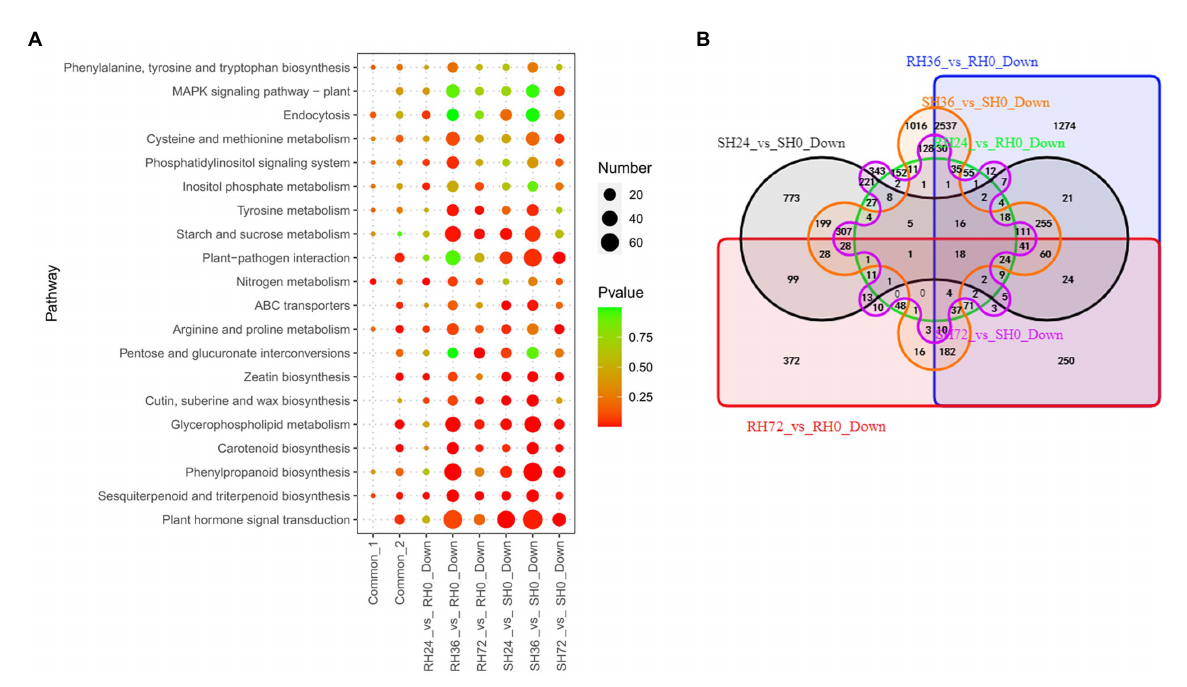
FIGURE 6 Identification of PAMPs induced susceptibility-response DEGs in RH24 vs. RH0, RH36 vs. RH0, RH72 vs. RH0, SH24 vs. SH0, SH36 vs. SH0, and SH72 vs. SH0. (A) KEGG enrichment analysis of common and down-regulated DEGs in each comparison group. Common-1 and Common-2 indicate the common up-regulated DEGs in RHs vs. RH0 and SHs vs. SH0, respectively. (B) A big Venn diagram of DEGs for down-regulated DEGs in RHs vs. RH0 and SHs vs.